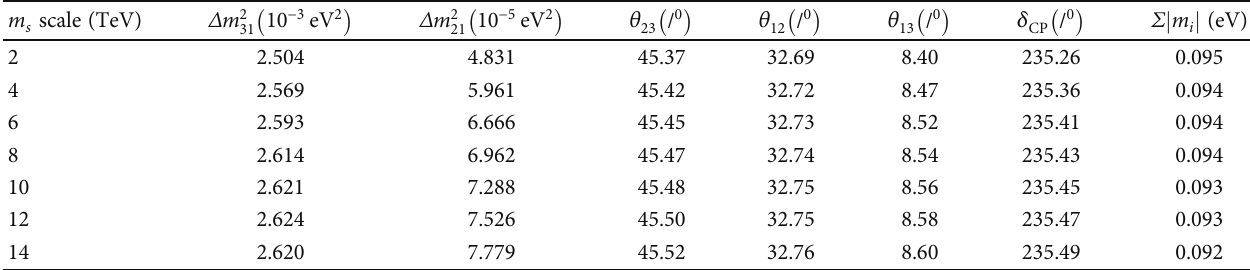
for NH case ( tan β = 40 , M s